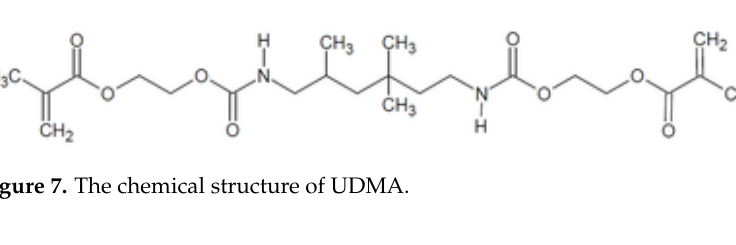
Figure 6. The chemical structure of Bis-GMA.